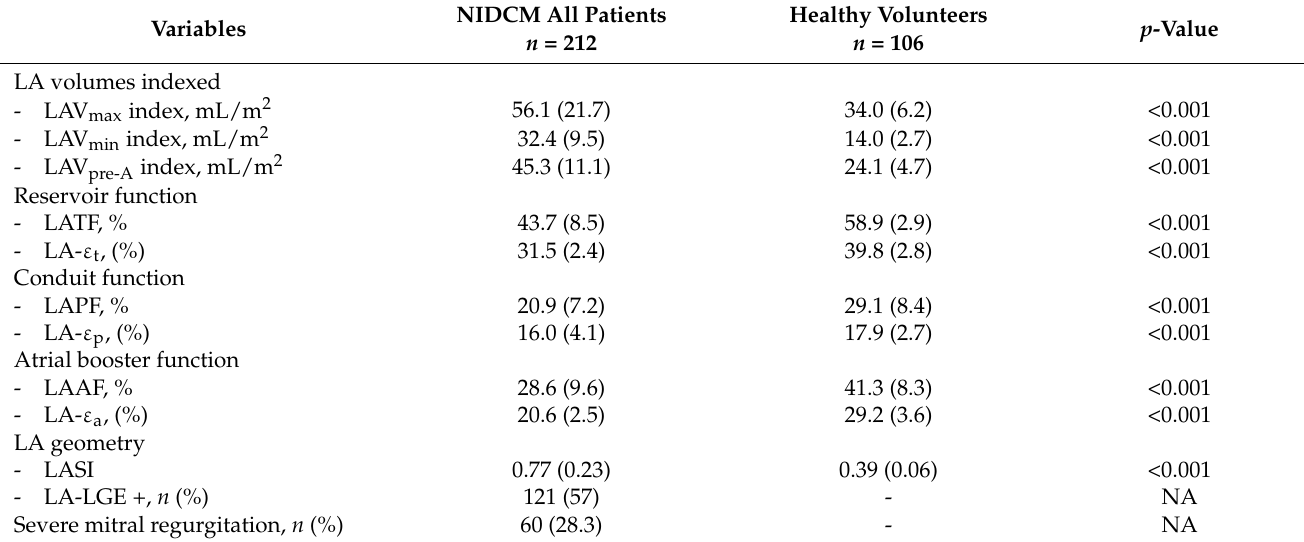
Table 3. Comparison between left atrial function and geometry parameters between NIDCM and healthy volunteers.